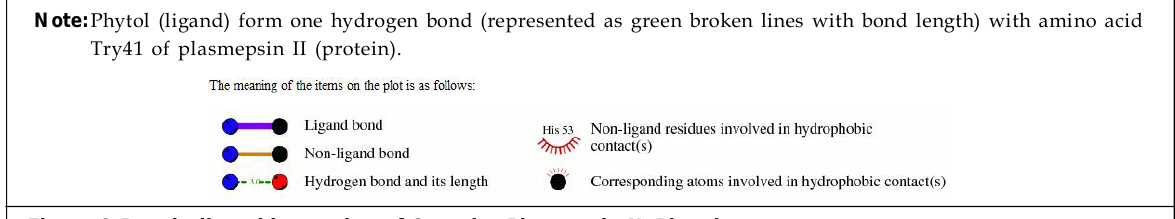
Figure 6: Protein-ligand interaction of Complex Plasmepsin II_Phytol